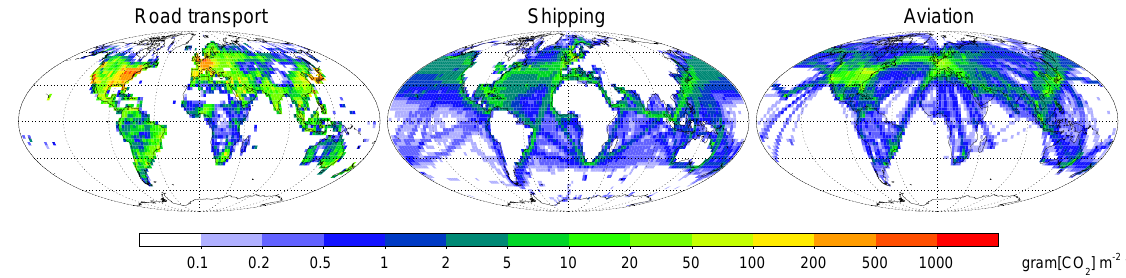
simulations allow the derivation of the contributions from the different transport sectors to the total CO 2 concentration and